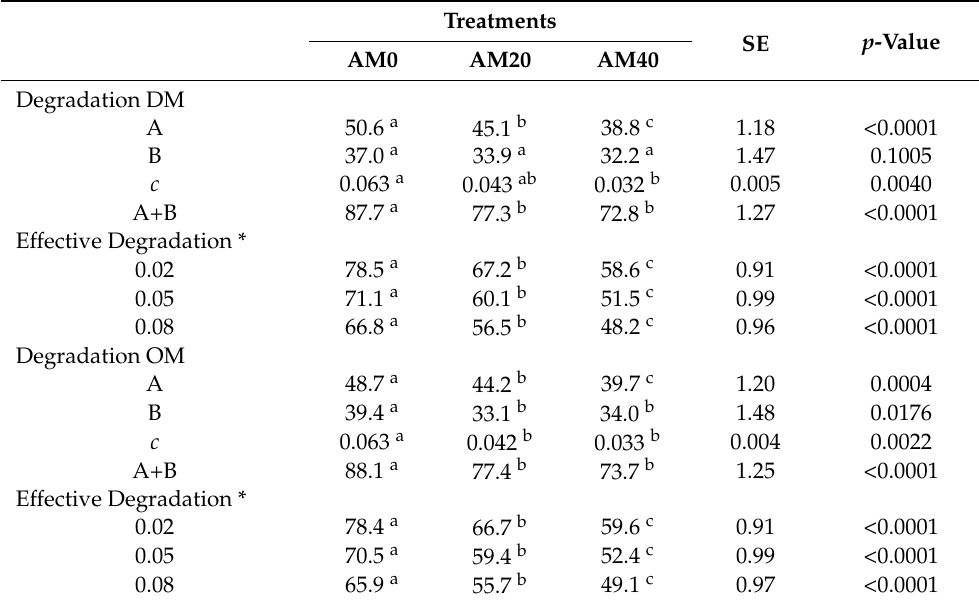
Table 2. In situ rumen degradation kinetics of DM and OM (%) of diets with increasing levels of Acacia Mearnsii (AM).